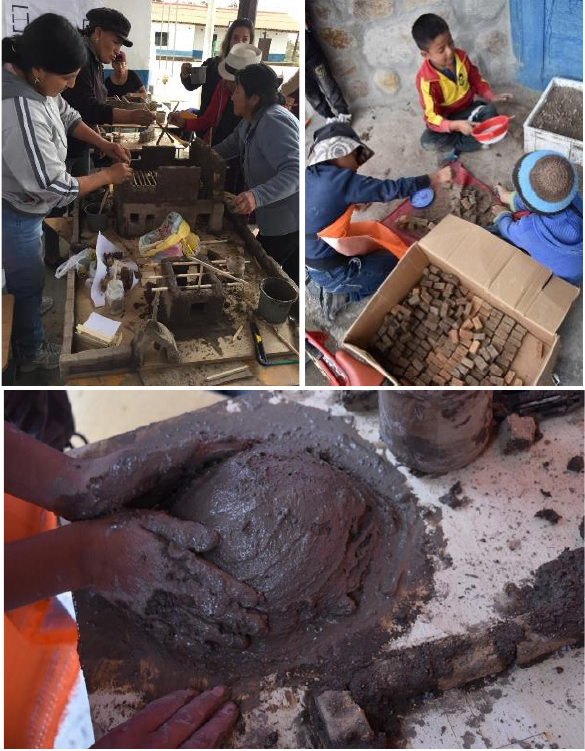
Figure 3. a) integration of adults to the workshop. b) laborious hands in the sifting of earth. c) missing photo of the